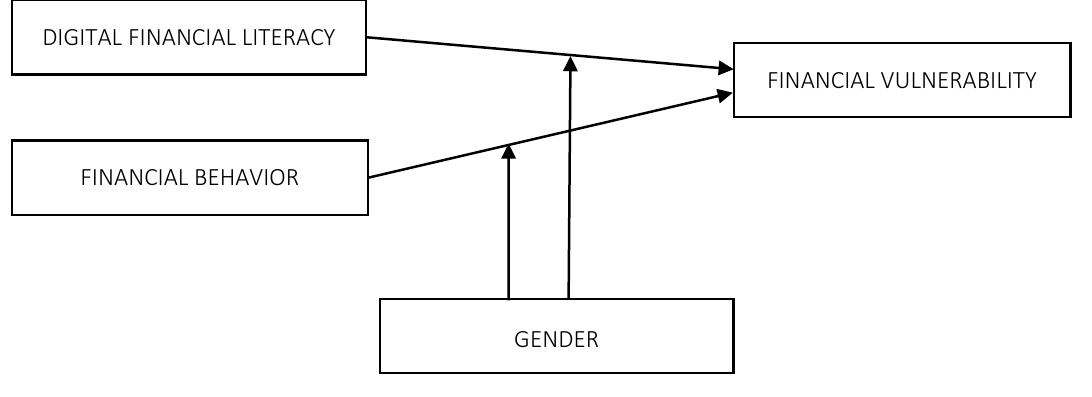
Figure 1. Research